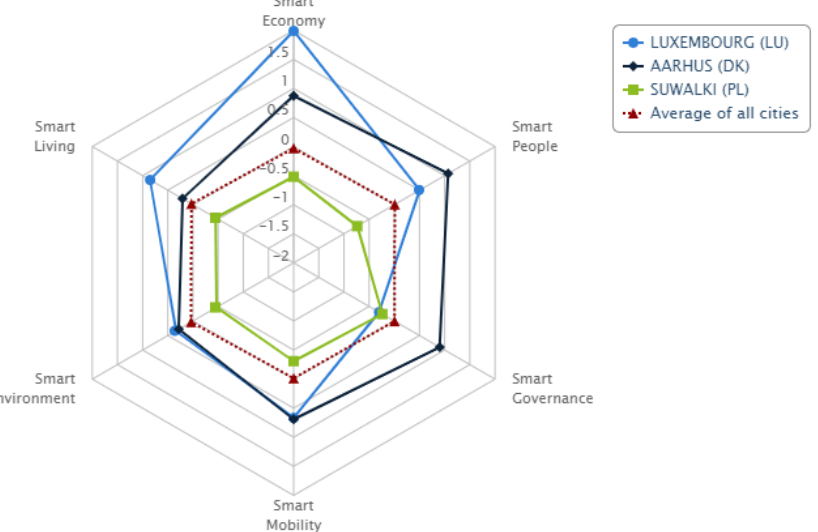
Figure 3. City profile: Suwalki (PL). Source: http://www.smart-cities.eu (accessed on 10 January 2023).